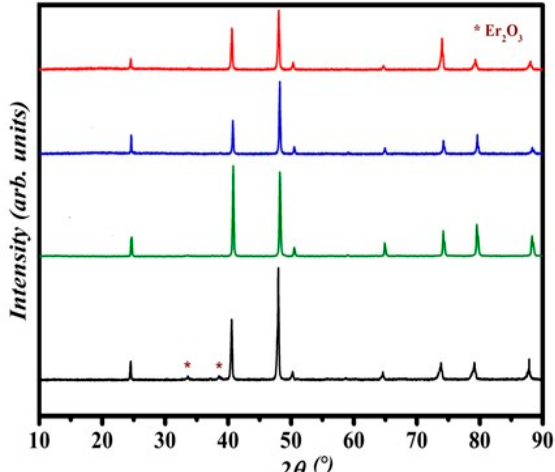
Figure 1. X-ray diffraction (XRD) patterns of Er(Fe 0.2 Mn 0.8 ) 2 , (black), Er(Fe 0.8 Mn 0.1 Co 0.1 ) 2 (green), Er(Fe 0.7 Mn 0.2 Co 0.1 ) 2 (blue), and Er(Fe 0.7 Mn 0.1 Co 0.2 ) 2 (red). A tiny amount of Er 2 O 3 impurity was detected for Er(Fe 0.2 Mn 0.8 ) 2 .